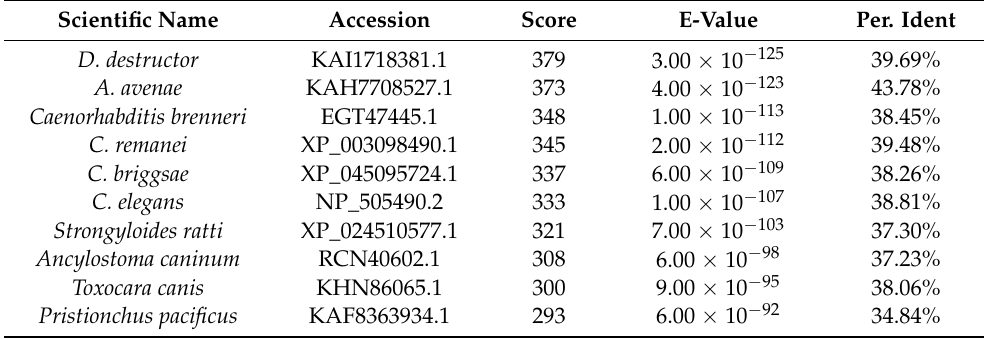
Figure 1. Phylogenetic analysis of Bx-cyp29A3 with CYPs from other nematodes. ( a ) Phylogenetic tree constructed by the maximum likelihood (ML) method; ( b ) phylogenetic tree constructed by the neighbor-joining (NJ) method. Table 1. Sequence homology comparison of Bx-cyp29A3 with other